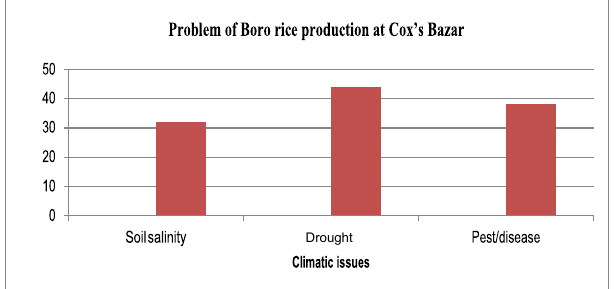
Figure 11: Farmers response on impacts of climate change on Boro